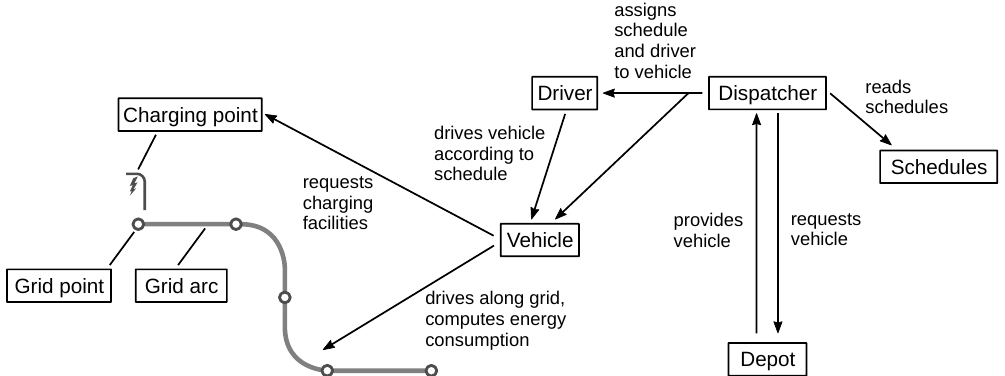
Figure 4. Simplified overview of the relationships between objects in the schedule simulation.